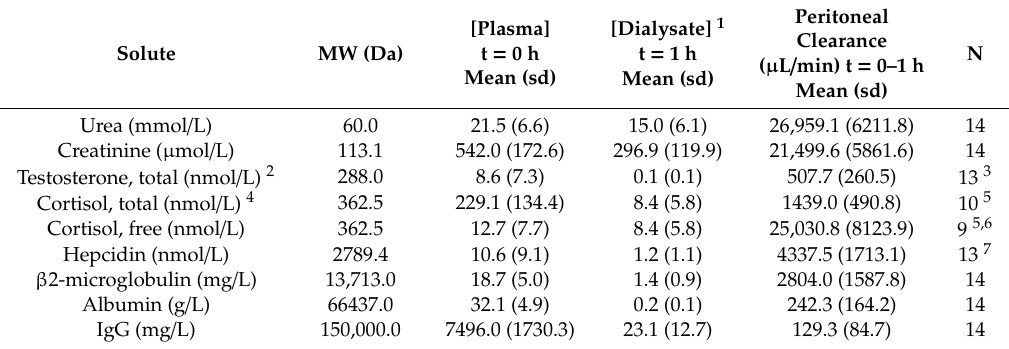
Table 2. Molecular weight, measured plasma, and dialysate concentrations (mean ± sd) and subsequent calculated peritoneal clearances (mean ± sd) for all solutes.